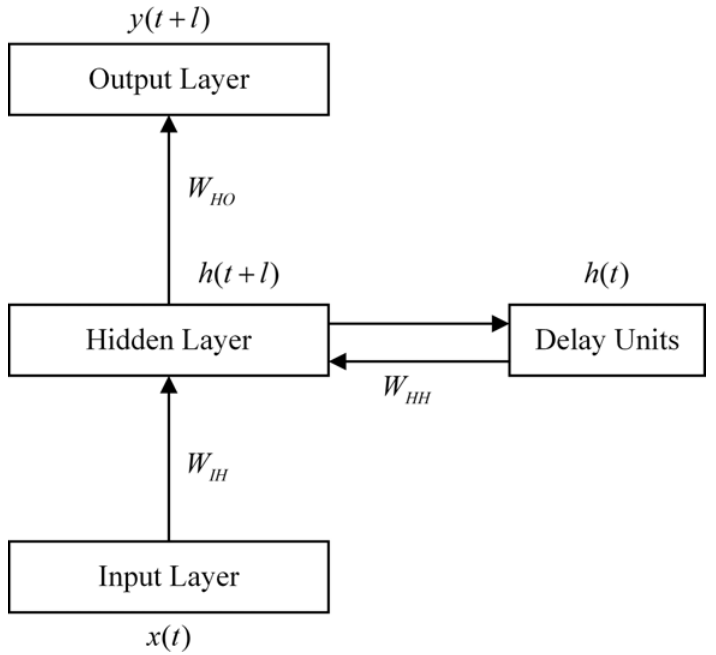
Fig 2. State Space Neural Network